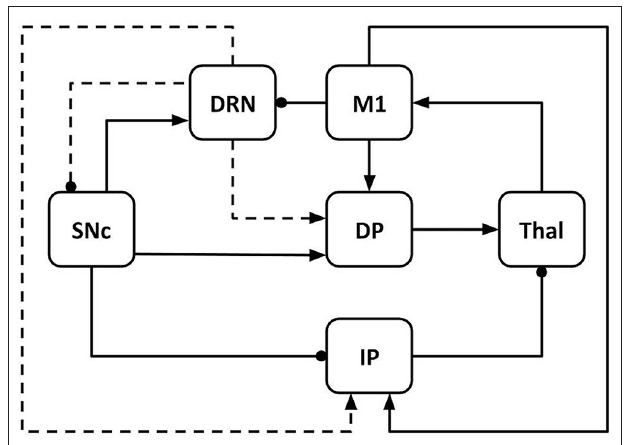
FIGURE 1 | Model architecture including primary motor cortex (M1), thalamus (Thal), dorsal raphe nucleus (DRN), substantia nigra pars compacta (SNc); basal ganglia direct pathway (DP); basal ganglia indirect pathway (IP). The connections linking different components can be excitatory (arrows) or inhibitory (lines ending with dot). The dashed lines indicate the effects of serotonergic projections from DRN to SNc, DP, and IP. Through these connections, serotonin modulates the dopamine release in the system.